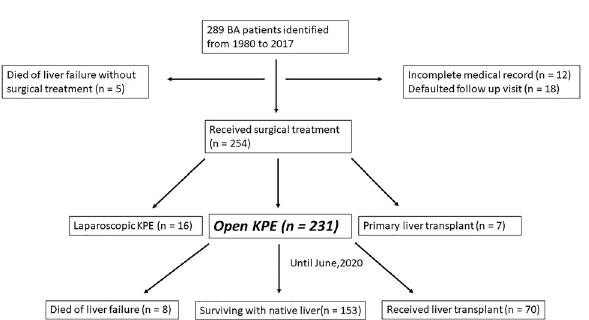
Figure 2. Flowchart of patient recruitment in this study. Ultimately, 231 BA patients with open KPE were analyzed for their clinical